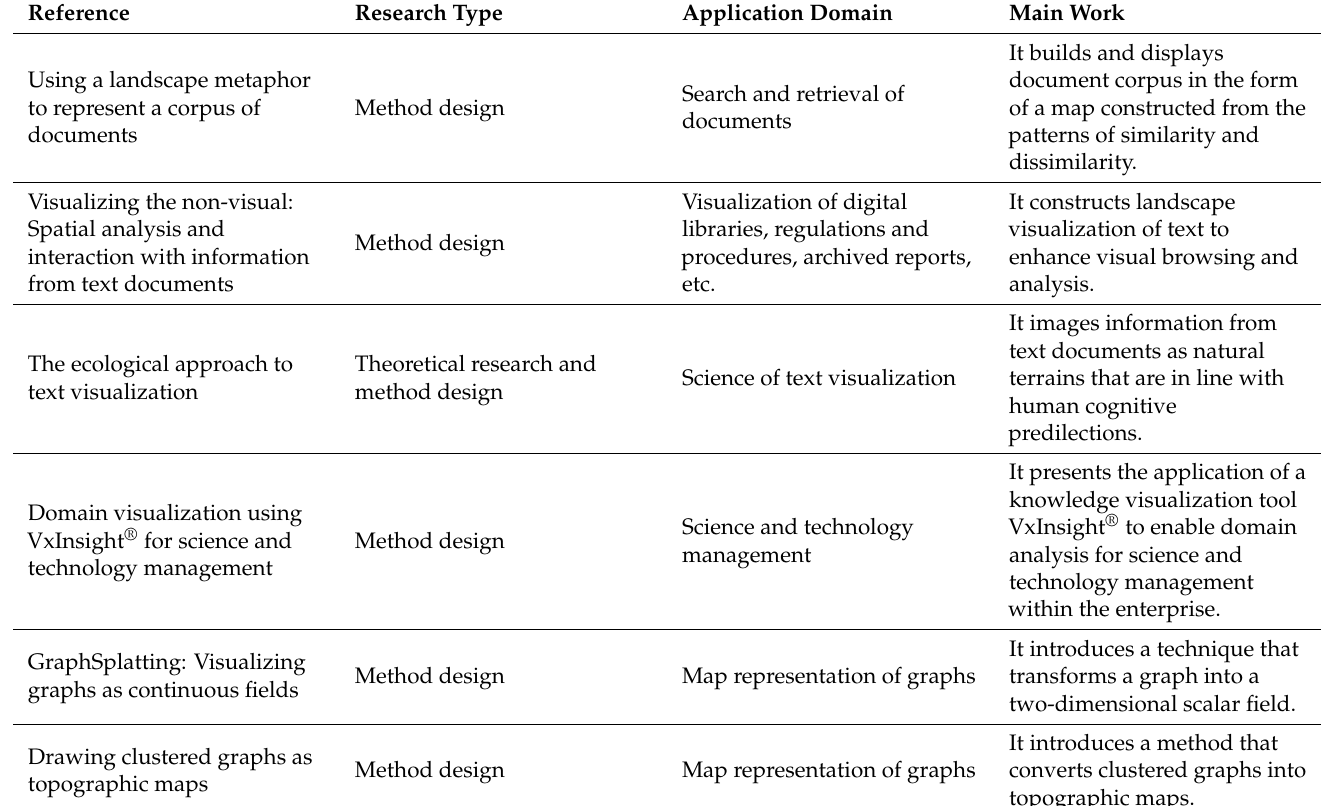
Table 1. Summary table of typical virtual terrain map-like visualization